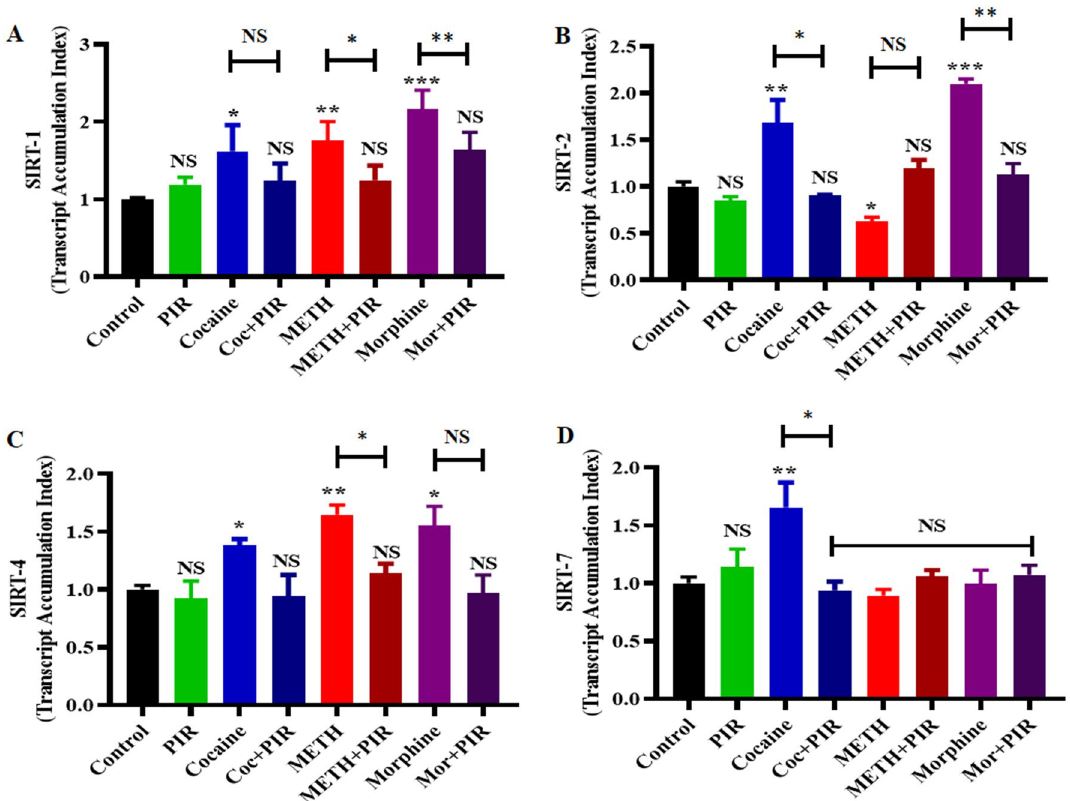
Figure 3. Piracetam reversed the effects of psychostimulants and opioids on the differential gene expression of SIRTs. Human primary astrocytes were exposed to cocaine (1 µM), METH (10 µM) or morphine (5 µM) alone or in combination with piracetam (10 µM) for 24 h. Controls were maintained in drug-free medium (without drug exposure). ( A ) SIRT-1, ( B ) SIRT-2, ( C ) SIRT-4, and ( D ) SIRT-7 mRNA expression levels in astrocytes determined using qRT-PCR analysis with the housekeeping gene β-actin as a loading control. The data are expressed as the means ± SD of the transcript accumulation index (TAI) (compared to control) of three independent experiments. ***P < 0.001, **P < 0.01, *P < 0.05, NS—Nonsignificant. Coexposure of psychostimulant or opioid with piracetam compared to psychostimulant or opioid